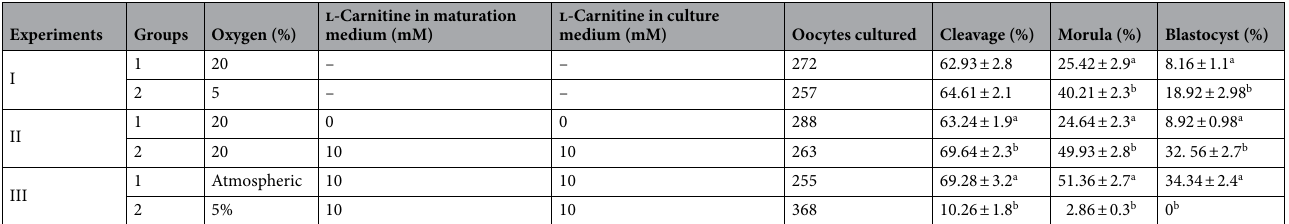
Table 1. Developmental stages of in vitro ovine embryos produced in different experiments. *All developmental stages were calculated from the number oocytes cultured. Percentage results are presented as mean ± S.E.M. Different superscripts within rows of same column differ significantly at P < 0.05 between groups of each experiment.